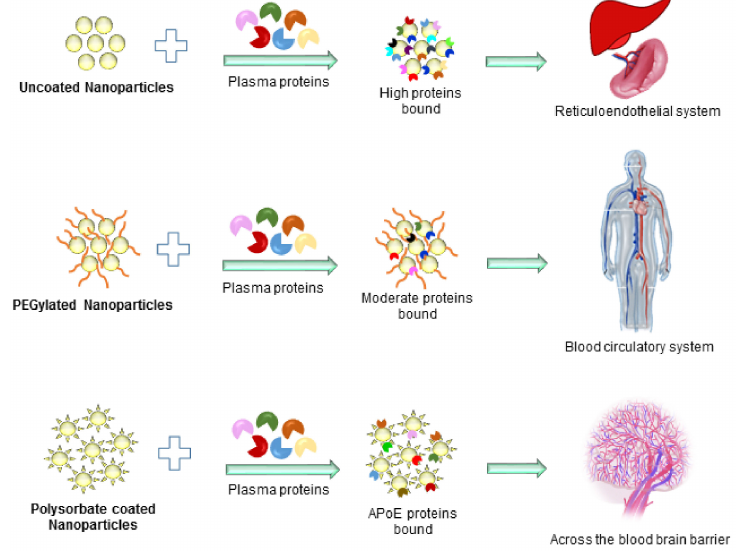
Figure 3. Distribution of nanoparticles with varying coatings and bound proteins. PEG =